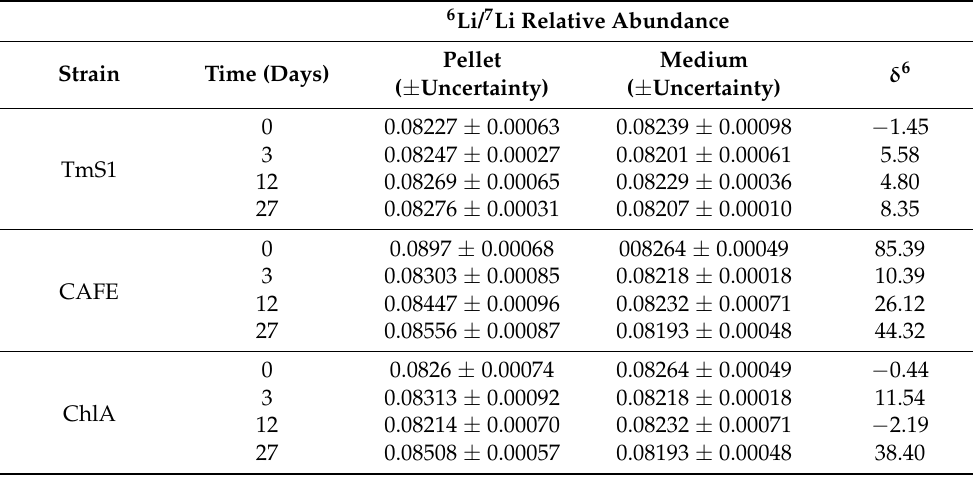
Table 3. 6 Li relative abundance and enrichment factor ( δ 6 ) in the experimental